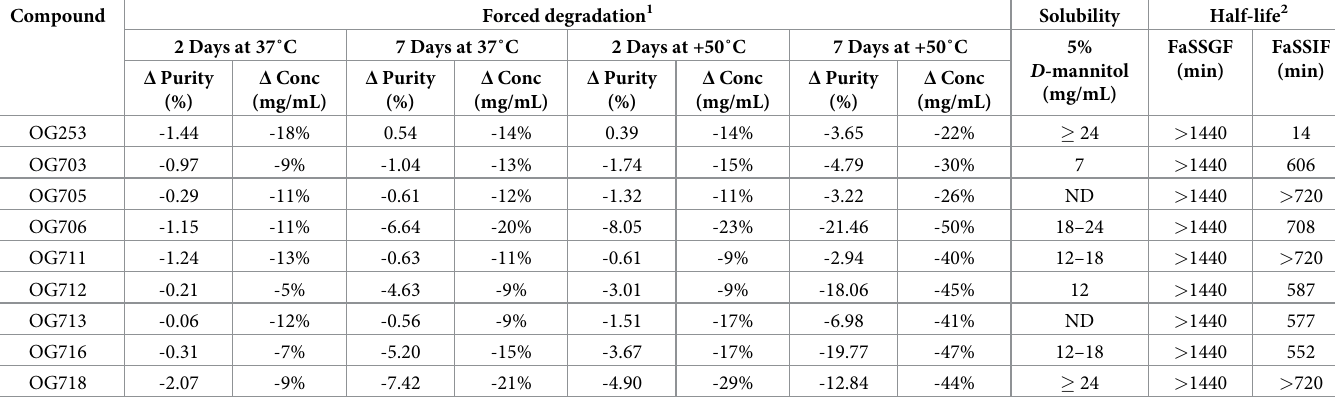
Table 4. Solubility, stability under forced degradation, and half-life in bio-relevant matrices.